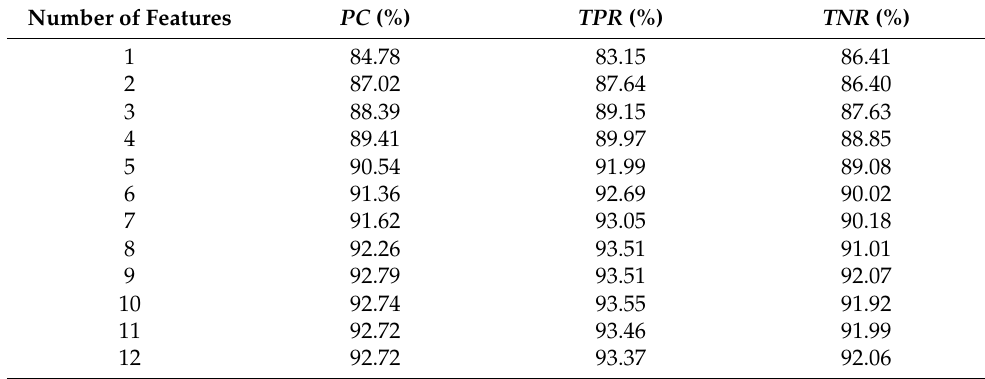
Table 5. The detection results of the validation set of the cloud detection model corresponding to the number of features from 1 to